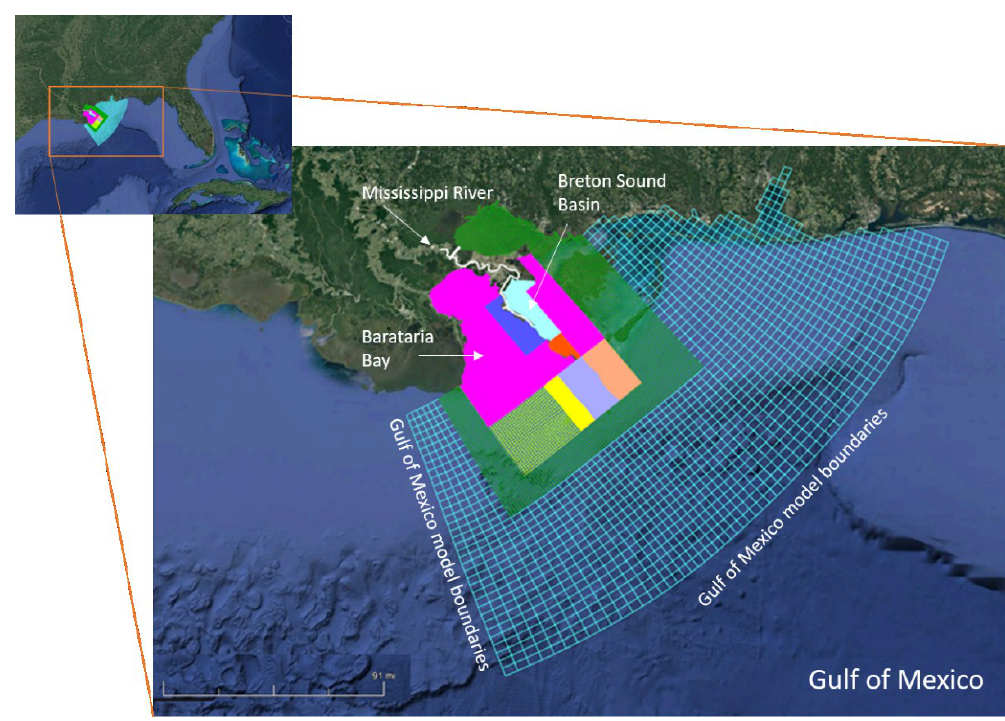
Figure 4. Basin-wide Delft3D model extension and subdivision in 12 domains.